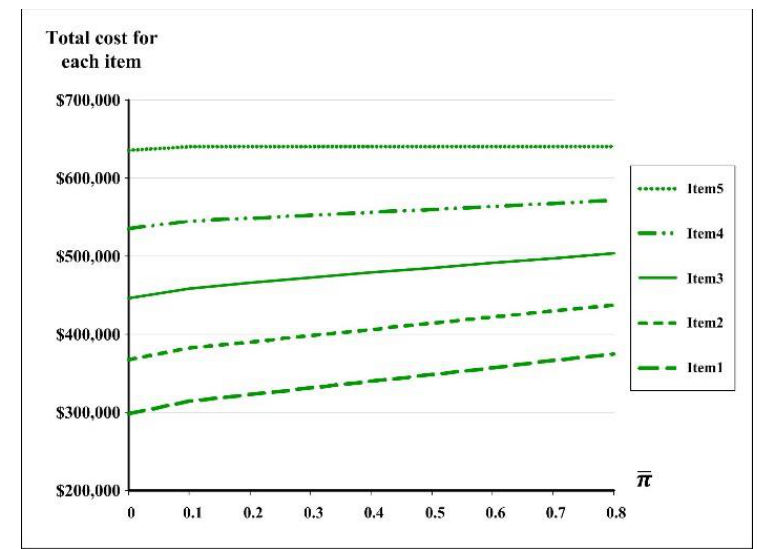
Figure 4. Impact of changes in  on each product’s total cost